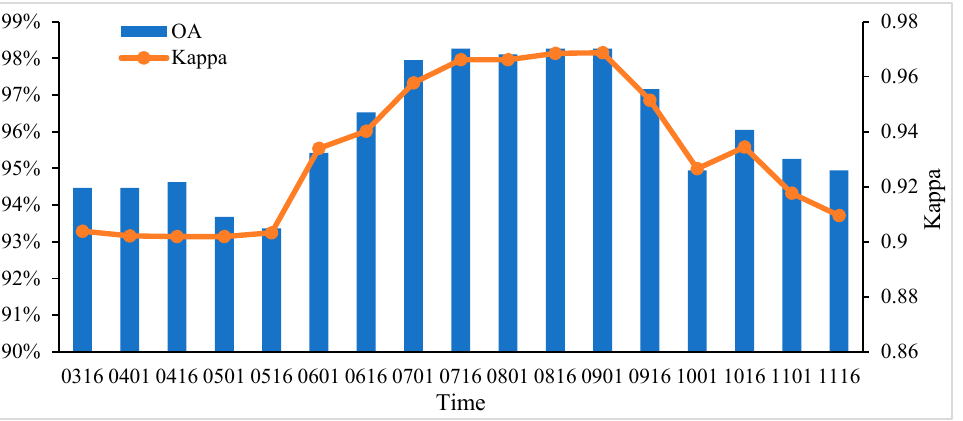
Figure 4. Overall accuracy (OA) and kappa coefficient of 15-day intra-annual classification results. Note: The times marked in the figure are the first dates of the 15-day Sentinel-2 composite images.